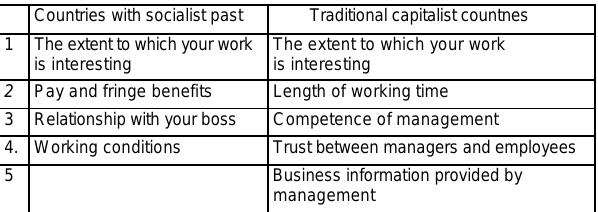
Table 3. Facets contributing to commitment to the company Countries with socialist